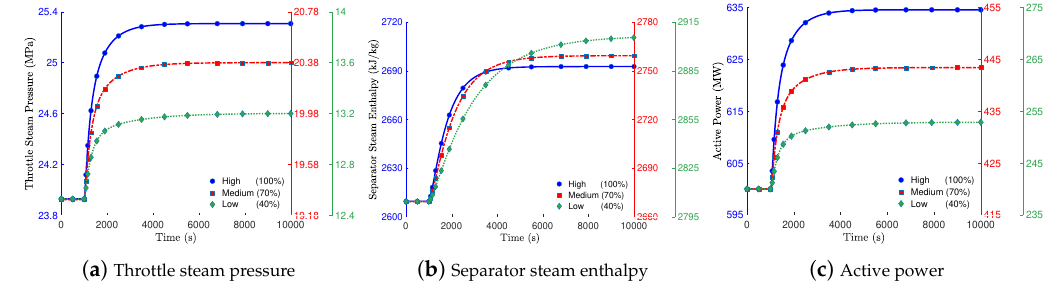
Figure 2. Outputs of a supercritical CFB unit when u B increases by